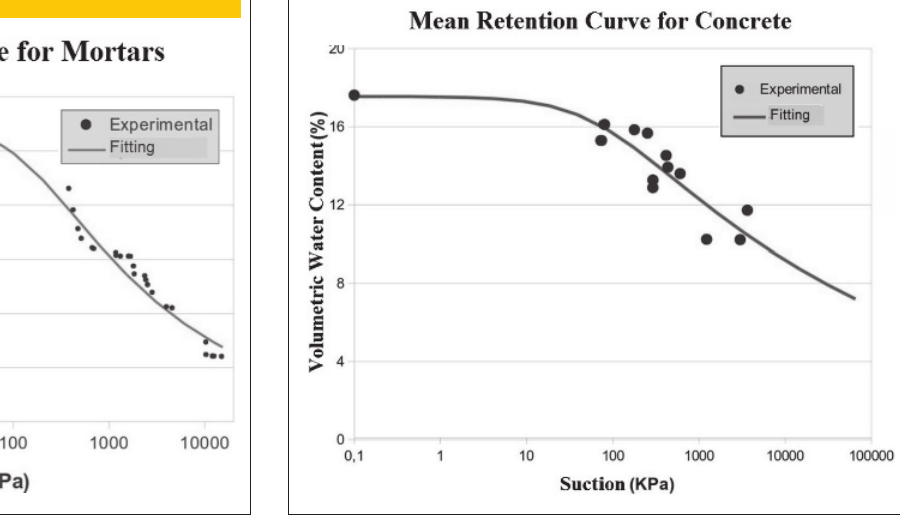
Figure 6 – Correlation between suction and the volumetric water content for concrete